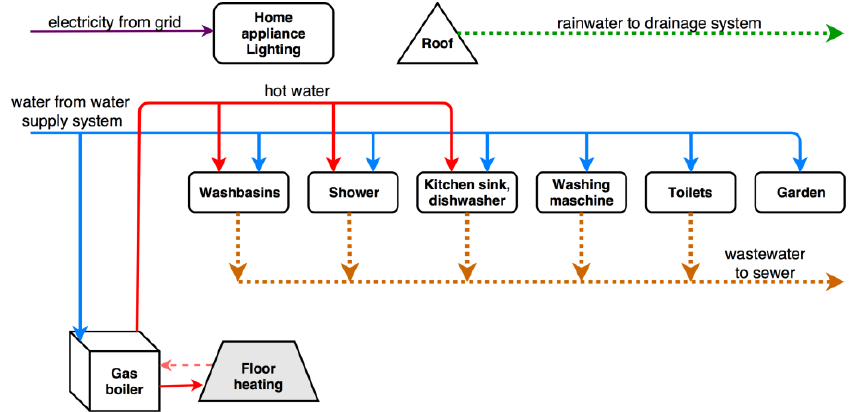
Figure 3. Diagram of system operation in Variant 0.